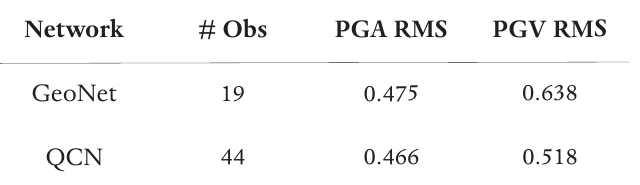
versus distance observed on QCN showing scatter in the observed accelerations. (c) PGV H H showing scatter in the observed velocities. Average RMS scatter is H